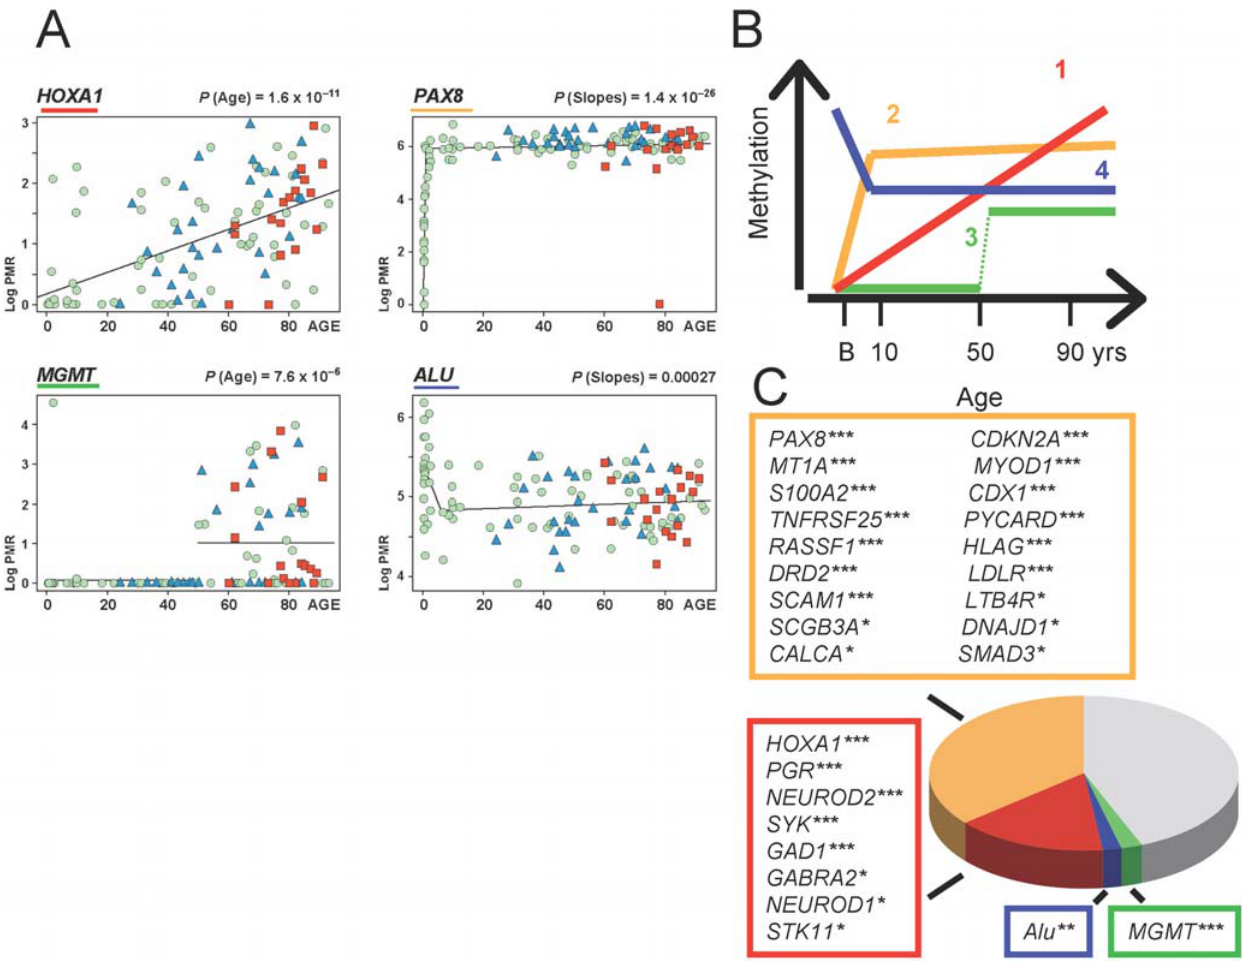
Figure 2. Four developmental profiles for cortical DNA methylation. (A) Associations of log-transformed PMR values (ln(PMR + 1); y-axis) with age (x- axis) for several representative genes. Trends are studied using linear regression. HOXA1 shows a linear association. MGMT -M2B shows a non-linear shift, with the P -value referring to a T -test of the difference in mean methylation value for subjects under or over 50 years of age. For the biphasic linear trends of PAX8 and the ALU sequence ALU-M1B (Table S2) , the P -values refer to a test of change of slope. Green dots=controls, blue triangles=schizophrenia and red squares=Alzheimer’s subjects. (B) Schematic summary of the four different types (1–4, see text for details) of developmental methylation profiles in human temporal cortex across the lifespan (x-axis, B=birth), as illustrated by the representative examples in (A). ( C ) Listings and proportion of gene loci (total=48; excluding AR and FAM127A which showed gender-specific methylation) that show significant age-dependent methylation changes: colors refer to the scheme in (B). Gray sector refers to the subset of loci without a significant age effect. N=125 subjects. All p-values are adjusted for diagnosis; *** p , 0.0001, ** p , 0.001, * p , 0.05.